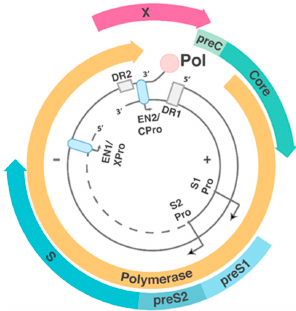
Figure 1. Open reading frames (ORFs) of hepatitis B virus (HBV) circular DNA form. Coloured blocks represent each of the four main open reading frames, and the associated promoters (Pro) and enhancers (EN1 and EN2, light blue ovals) are shown. The direct repeat regions (DR1 and DR2, grey boxes) play important roles in hepatitis B virus (HBV) replication (seen in Figure 2). The large, medium and small forms of HBsAg are translated from the preS1 + preS2 + S, preS2 + S and S alone ORF, respectively. Pol is encoded by the polymerase ORF. HBV core antigen (HBcAg) is translated from the core ORF alone. HBV e antigen (HBeAg) is formed by the cleavage of the translated product from PreC + core ORF. HBV X protein (HBx) is translated from the X